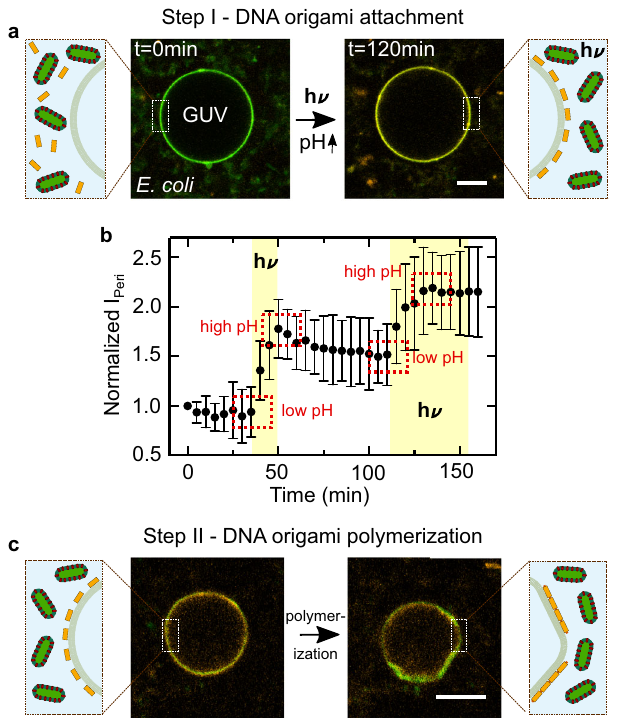
Fig. 5 Light-harvesting E. coli trigger DNA origami attachment and GUV deformation. a Confocal images of a GUV ( λ ex = 488 nm, green) functionalized with cholesterol-tagged DNA immersed in an E. coli and DNA origami ( λ ex = 561 nm, orange) containing solution before (left) and after (right) light illumination. Scale bar: 10 μ m. After light illumination, the DNA origami (orange) attaches to the GUV due to the pH increase triggered by the E. coli . b Normalized fl uorescence intensity I peri (mean ± s.d., n = 11) of the triplex-forming DNA at the GUV periphery monitored over time. The time period of illumination is indicated in yellow, illumination leads to a pH increase and hence DNA origami attachment. c Confocal images of a GUV ( λ ex = 488 nm, green) after light-mediated DNA origami ( λ ex = 561 nm, orange) attachment to the membrane and addition of the DNA staple strands at the scaffold seam which enable blunt-end stacking. DNA origami polymerization leads to the deformation of the GUV membrane within 2 h. Scale bar: 10 μ m. Source data is available for Fig.